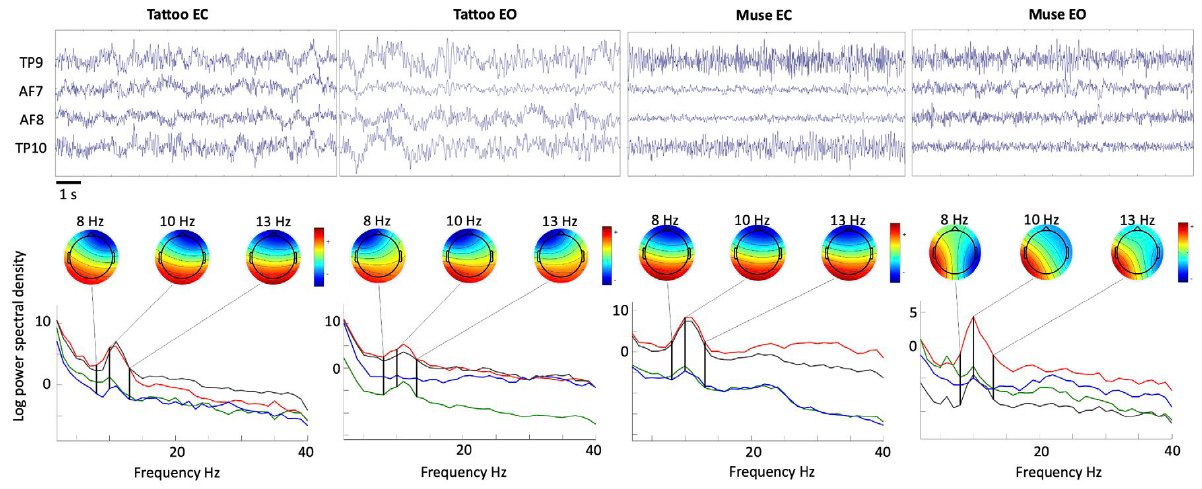
Figure 3. Exemplifying time-course of the EEG traces, channel spectra and maps for the two different acquisition systems and two different experimental conditions. EC and EO, respectively, refer to resting-state eyes-closed and eyes-open conditions. Each line represents a different channel, namely TP9 (red), TP10 (black), AF7 (green), AF8 (blue).